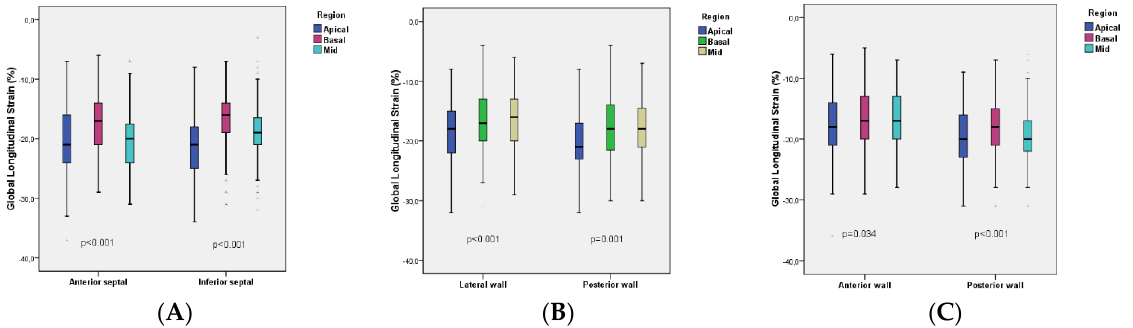
Figure 7. The range of peak longitudinal systolic strain values at basal, mid, and apical regions in the six left ventricular standard segments. The best values were obtained in basal regions at anterior and inferior septal levels ( p < 0.001, in both, A ), mid regions at lateral wall ( p < 0.001) and posterior wall levels ( p = 0.001) ( B ), and basal regions at anterior wall ( p = 0.034) and posterior wall levels ( p < 0.001) ( C ).